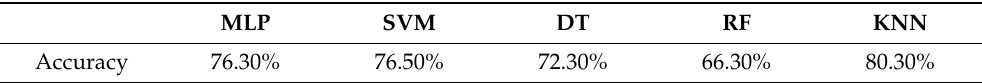
Table 10. Classification results for Dataset 06 (Obesity/non-Obesity).